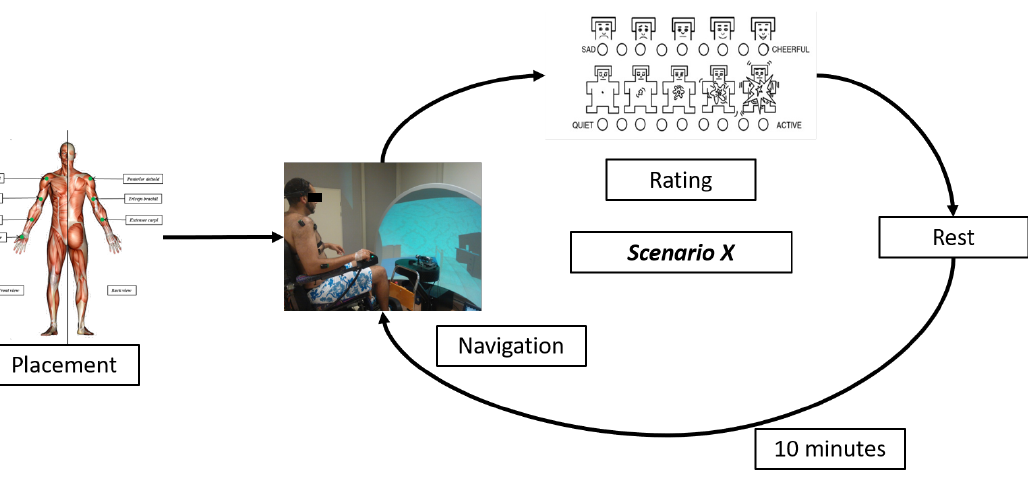
Figure 4. A summary of the experiment